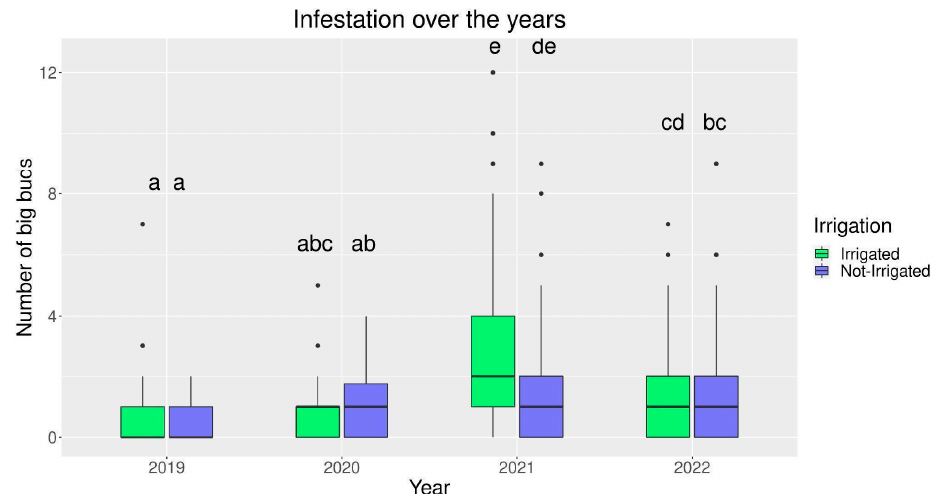
Figure 2. Overall infestation of hazelnut plants over the four years of survey, distinguishing between irrigated and not-irrigated plants. Different letters indicate significant difference between the year of survey, irrigated and not-irrigated plants after Bonferroni post hoc test at p < 0.05.